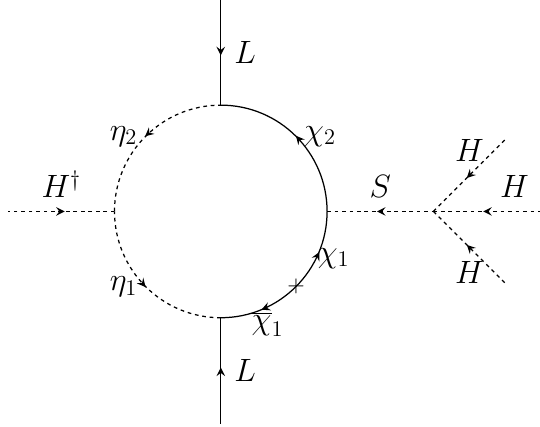
Figure 11 . Example of a d = 7 1-loop model with an external quadruplet S = 4 S from the diagram T16-ii in (cid:12)gure 19. This model contains only doublet and triplet representations inside the loop, see